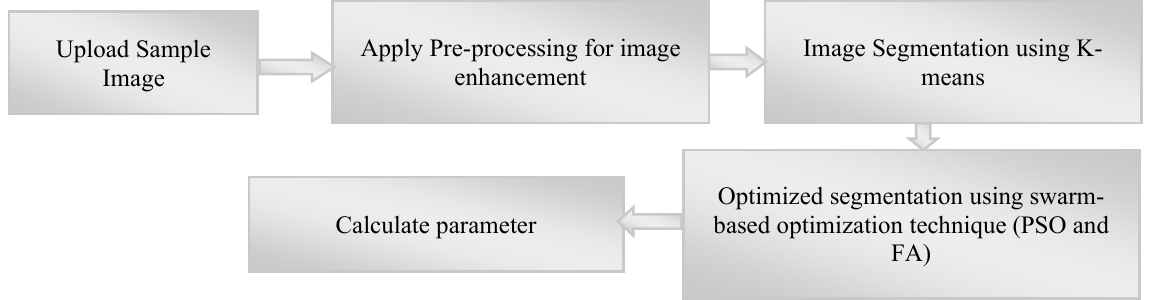
Figure 2. Workflow Diagram